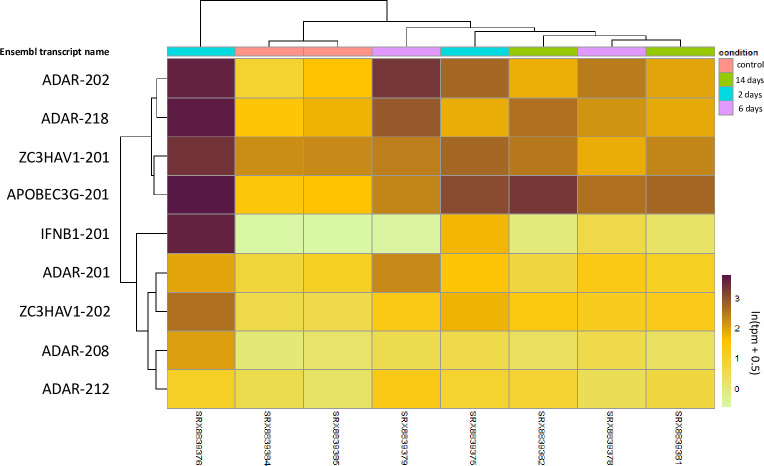
Differential expression of statistically significant transcripts of interest from LoM lung epithelial cell samples at varying time points after infection with SARS-CoV-2.Entries depict ln(tpm + 0.5) transformed fold-changes in kallisto-derived TPM values, from light green (lower) to dark purple (higher). Columns represent each experimental sample with its associated condition (time after infection) shown at the top. Each row represents a particular Ensembl transcript name, which is indicated to the left. Columns and rows are hierarchically clustered by similarity.